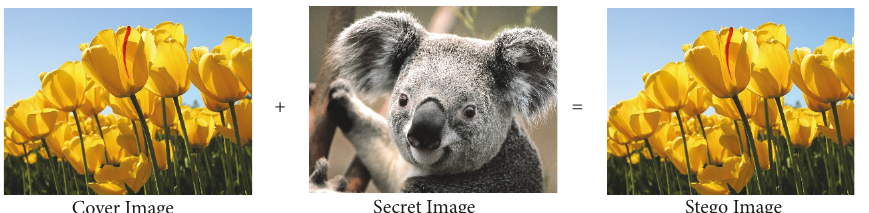
Figure 7: Encoding by max-plus algebra.